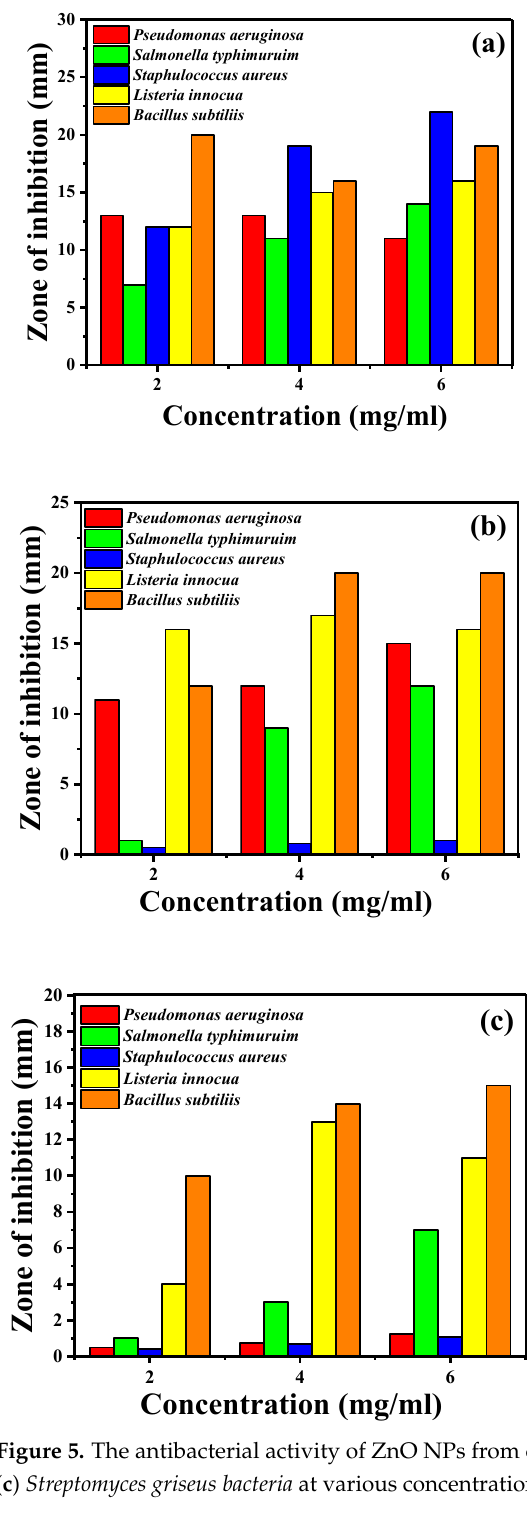
Figure 5. The antibacterial activity of ZnO NPs from chitosan of ( a ) shrimp shells , ( b ) crab shells and ( c ) Streptomyces griseus bacteria at various concentrations against different bacteria.